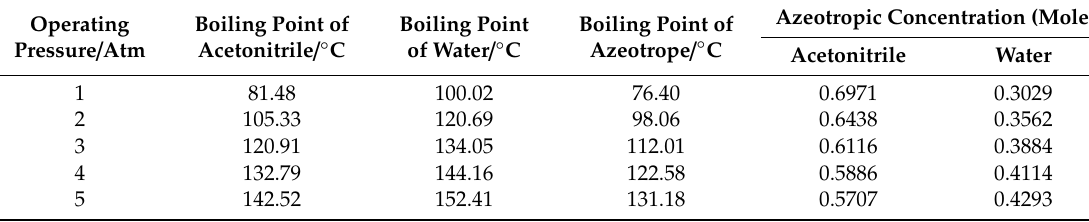
Table 1. E ff ect of the pressure on acetonitrile–water